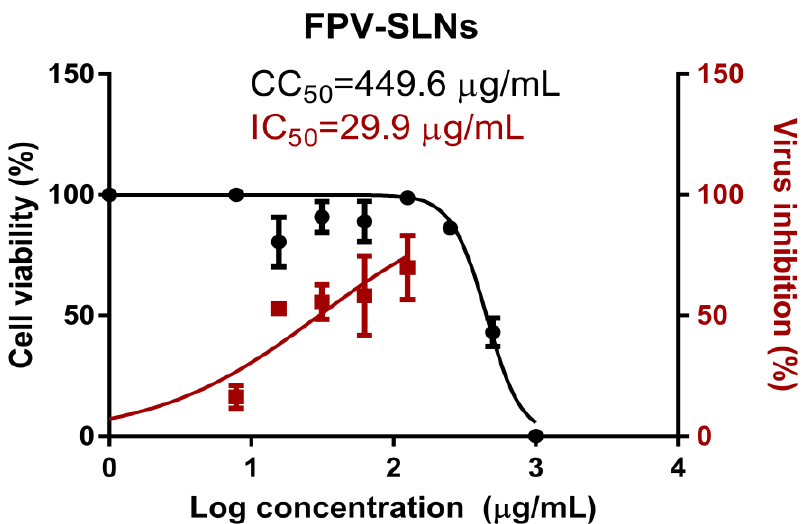
Figure 7. Determination of the antiviral activity of FPV-SLNs against severe acute respiratory syndrome coronavirus 2 (SARS-CoV-2). The dots represent the cell viability readouts at different treatment concentrations, and the squares represent the virus inhibition percentages of the treatment on Vero E6 cells. Data represent mean ± SD ( n =